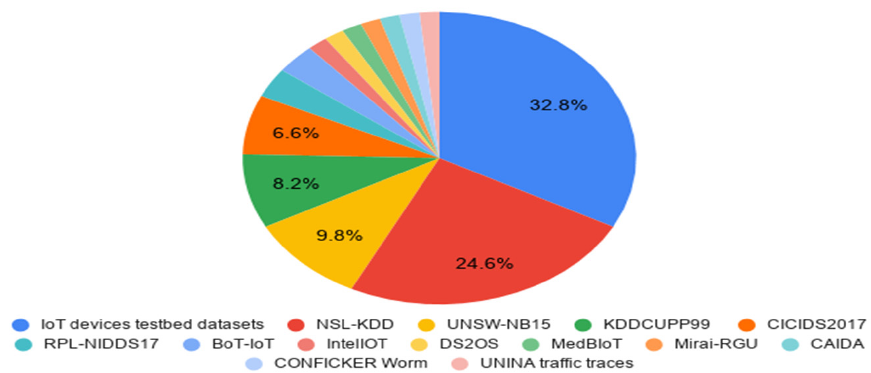
Figure 2. Distribution of IoT attack datasets.